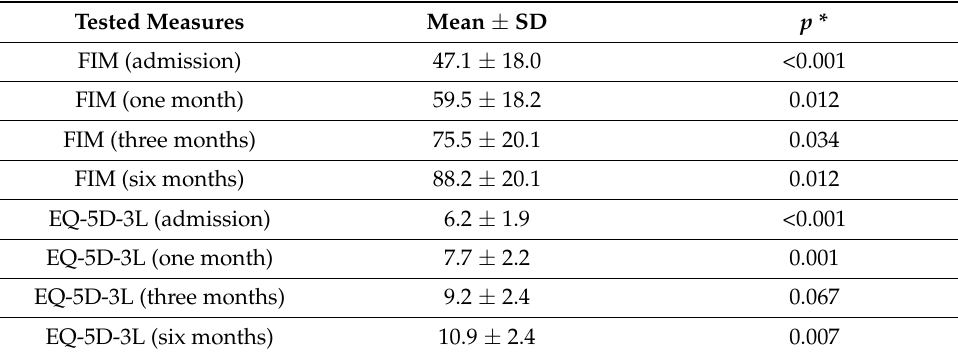
Table 2. Descriptive statistics for FIM and EQ-5D-3L questionnaire at different times of observation and results of test of normality.